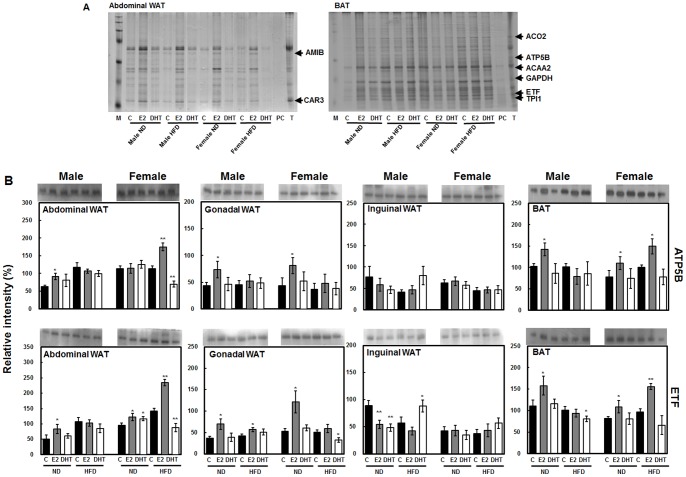
Representative silver-stained SDS-PAGE images of co-immunoprecipitated samples of abdominal WAT and BAT (M: maker, C: control, E2: E2-treated, DHT: DHT-treated, PC: positive control, T: total protein).Proteins were identified by PMF and indicated by black arrows along with their abbreviated names. AMIB: N-acetylmuramoyl-L-alanine amidase; CAR3: carbonic anhydrase 3; ACO2: aconitate hydratase, mitochondrial precursor; ATP5B: ATP synthase (H+ transporting, mitochondrial F1 complex, beta polypeptide); ACAA2: acetyl-CoA acyltransferase 2, mitochondrial; GAPDH: glycerol 3-phosphate dehydrogenase; ETF: electron transfer flavoprotein, subunit beta (ETF); TPI1: triose phosphate isomerase 1 (A). Protein levels of two major mitochondrial proteins, ETF and ATP5B, were identified by PMF in abdominal WAT and BAT (B). Band densities were normalized using β-actin in each tissue to calculate relative intensity (%). Statistical significance between control and hormone treated groups were calculated by Student’s t-test, where, *p<0.05 and **p<0.01. The significance of the effects of sex, diet and hormonal treatments was tested using multivariate ANOVA (M-ANOVA), where p<0.05.